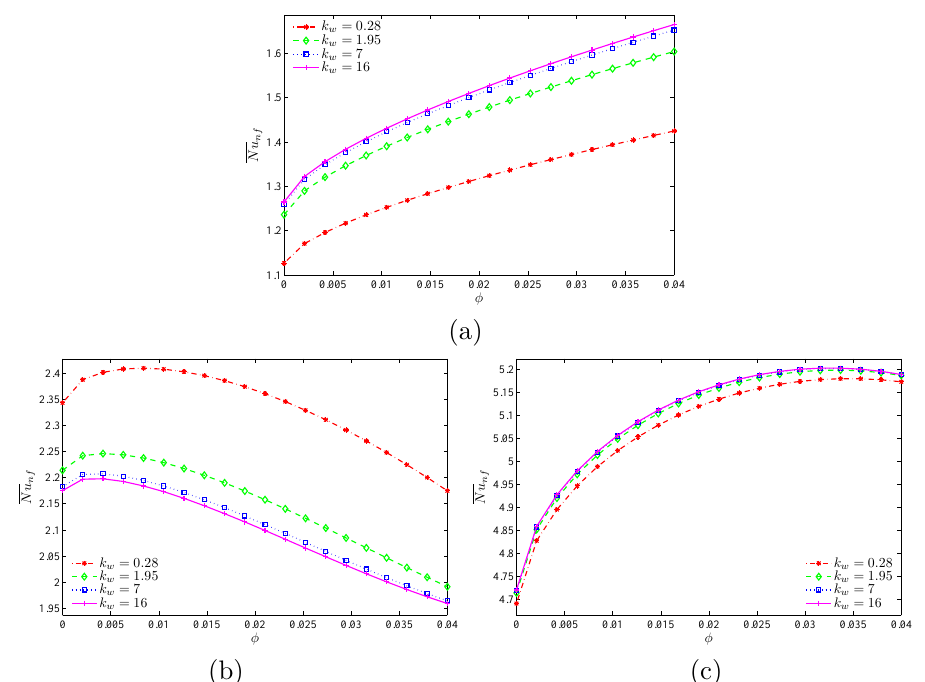
Figure 15. Variations of average Nusselt number with φ for different k w for ( a ) Ra = 10 2 , ( b ) Ra = 10 4 and ( c ) Ra = 10 5 at D = 0.3.